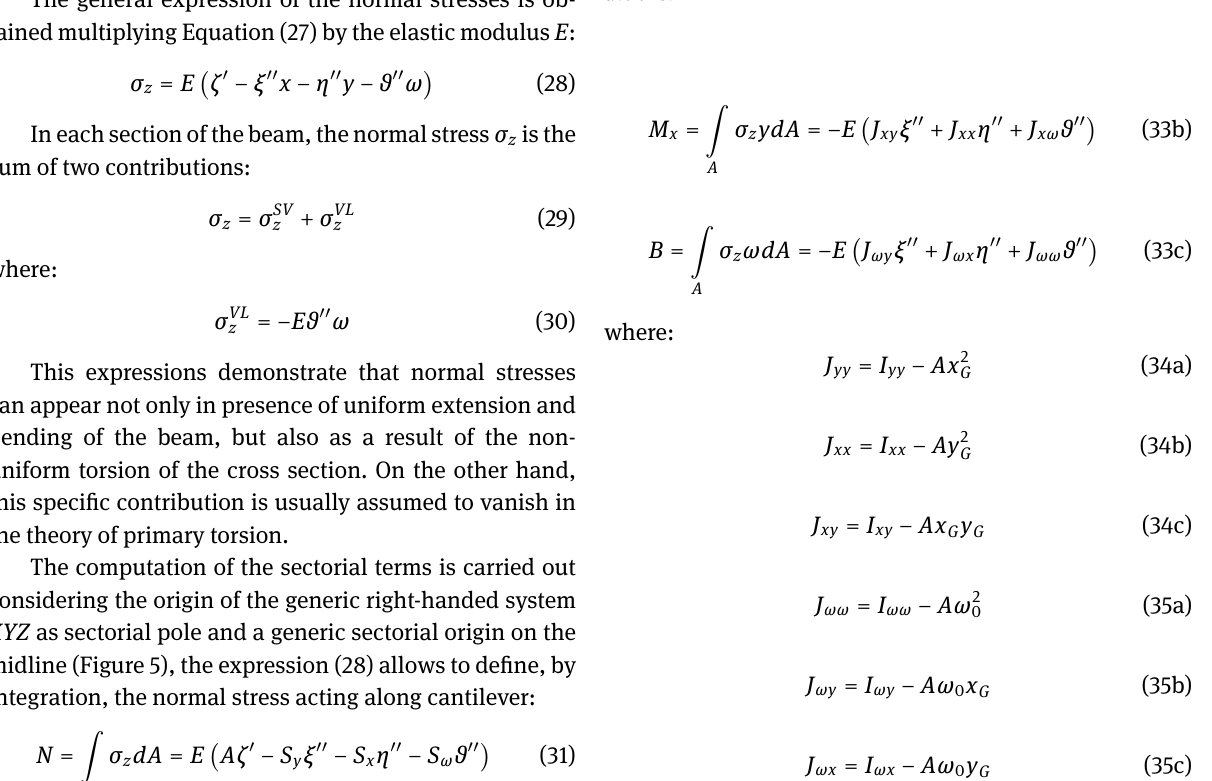
Figure 5: Thin-walled open-section beam subjected to transversal